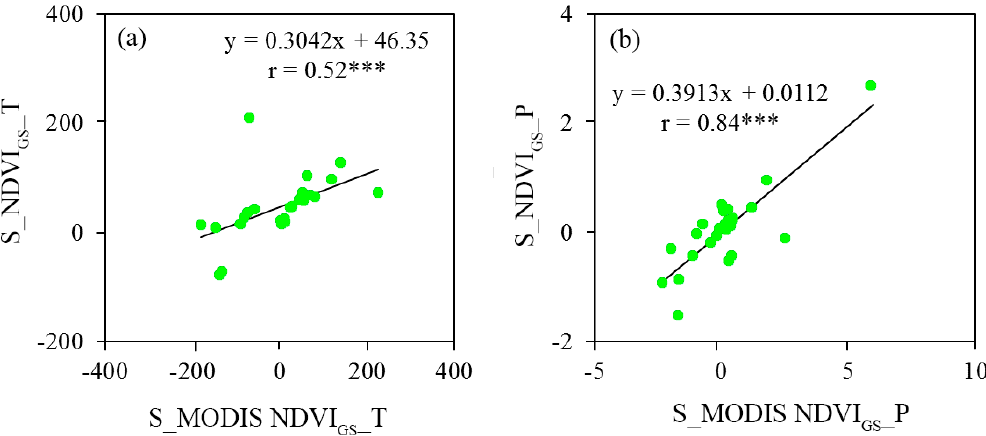
Figure 7. Correlation between the sensitivities of the elevational movements of GIMMS NDVI GS and MODIS NDVI GS to temperature (S_NDVI GS _T and S_MODIS NDVI GS _T) ( a ) and to precipitation (S_NDVI GS _P and S_MODIS NDVI GS _P) ( b ). *** indicates the significant correlation at the level of p < 0.001.